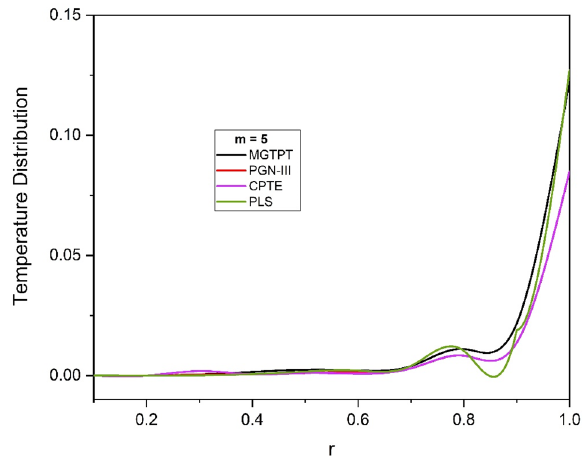
Fig. 10 The change in radial stress for different